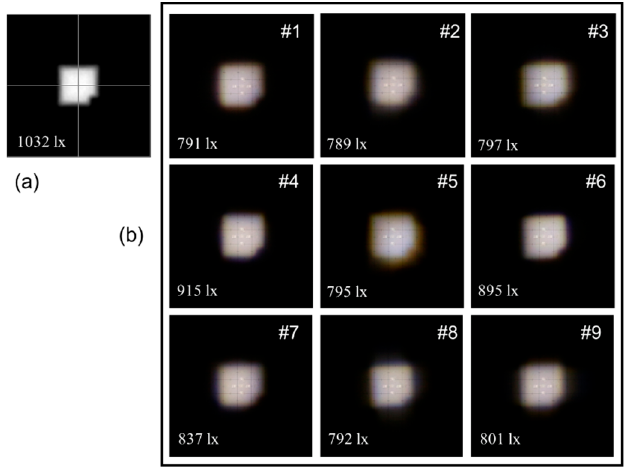
Figure 10. ( a ) Simulated projection spot of the cover lens at a distance of 10 m and ( b ) corresponding measurement for the nine samples. The measurements were conducted at an injection current of 1.5 A with a heavy heat sink.